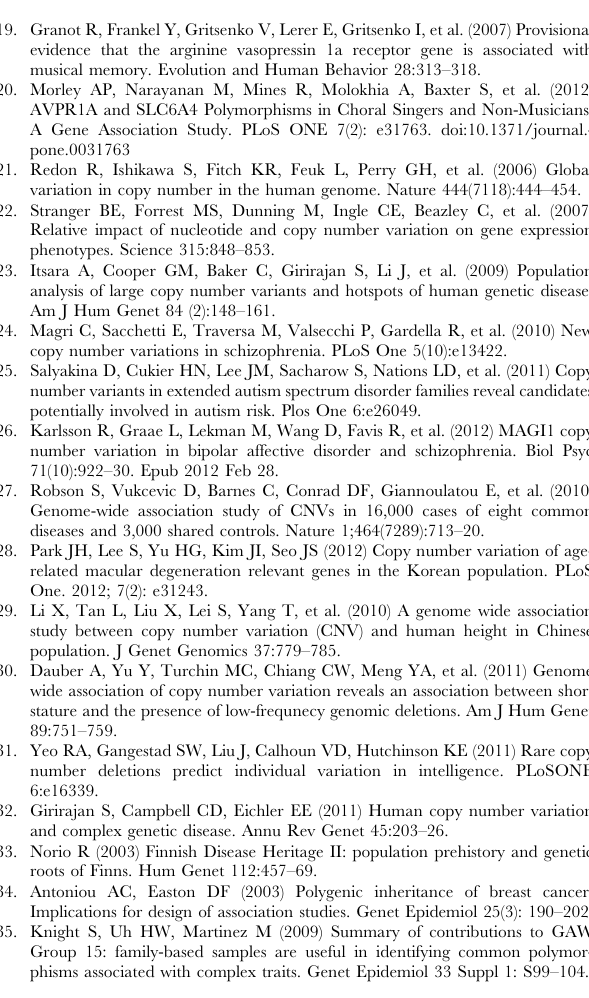
Table S1 All CNVRs ranked for COMB scores in the five study families. Table S2 Rare CNV burden analysis by event type and size in High COMB VS low COMB subjects. Table S3 All CNVRs ranked for creative functions in music in the five study